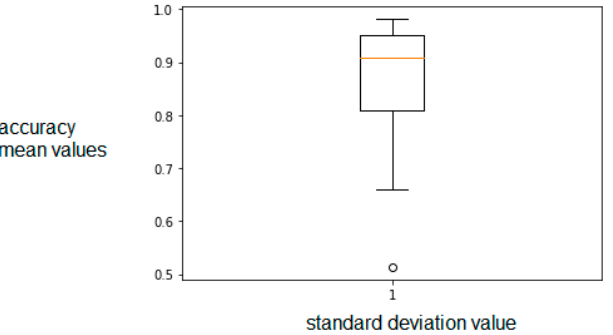
Figure 6. MobileNet Model performance.